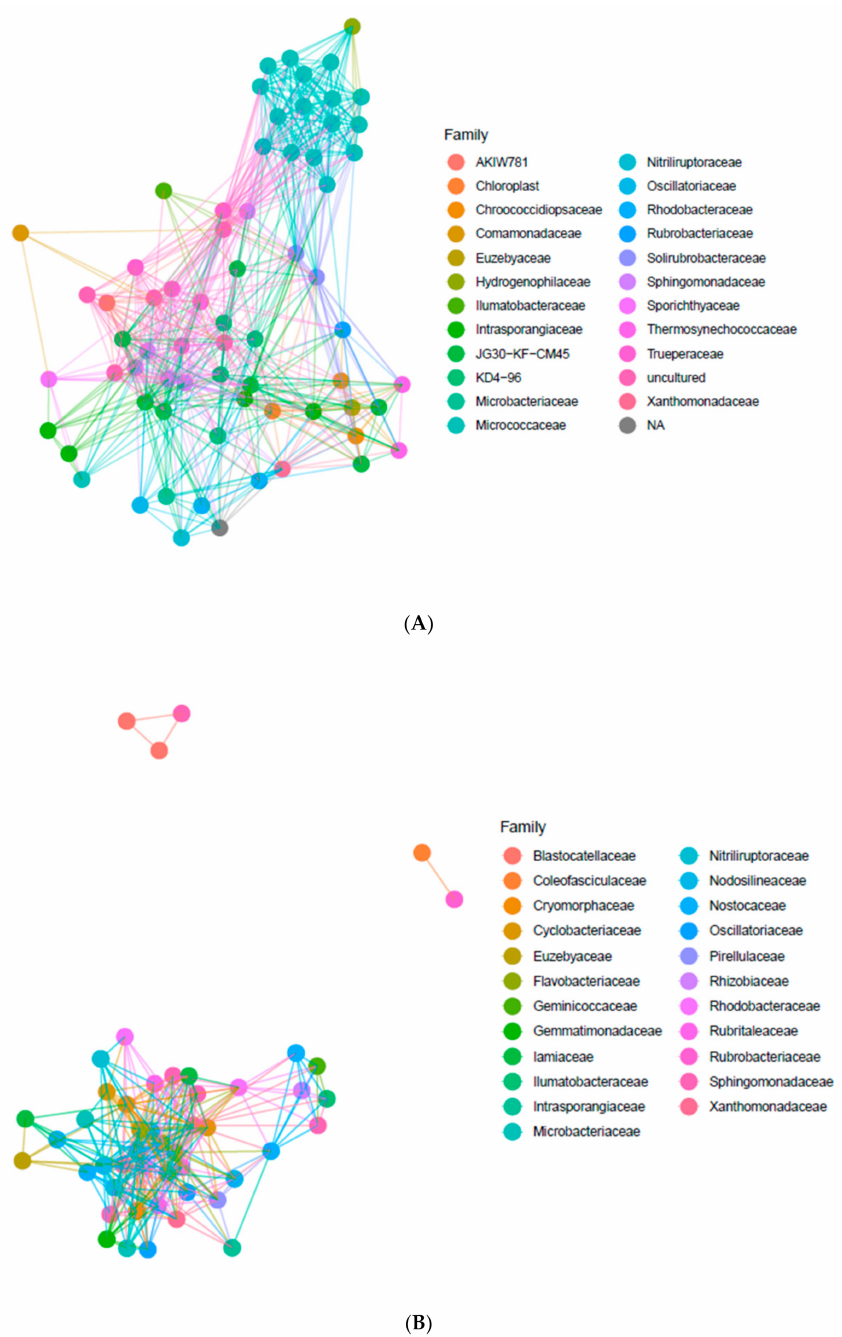
Figure 4. Co-occurrence of the most abundant bacterial ASVs in the endolithic microhabitat ( A ) and the BSCs ( B ). The sequence variants with a total abundance of less than 100 were removed. The distances calculated using the Bray–Curtis dissimilarity index with a maximum distance of 0.95. The most abundant bacterial families identified in the BSC were represented by Xan- thomonadaceae and Sphingomonadaceae belonging to Proteobacteria, Flavobacteriaceae and Cytophagaceae from Bacteroidetes, Iamiaceae, Nitriliruptoraceae and Euzebyaceae belonging to Actinobacteria, Pirellulaceae belonging to Planctomycetes and finally Nodosi- lineaceae, Nostocaceae, Coelofasciculaceae and Oscillatoriaceae belonging to Cyanobacteria (Figure 4B). Some ASVs belonging to Coelofasciculaceae, Blastocatellaceae and Rubrobacte- riaceae co-occur in the communities and were separated from other